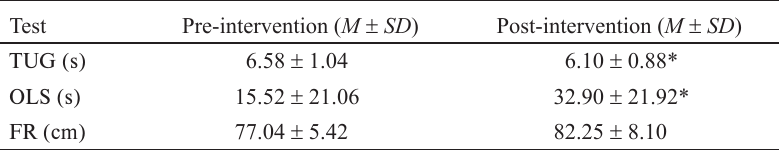
Pre and post-intervention comparison of Timed Up-and-Go (TUG), One-Leg Stance (OLS), and Functional Reach (FR)